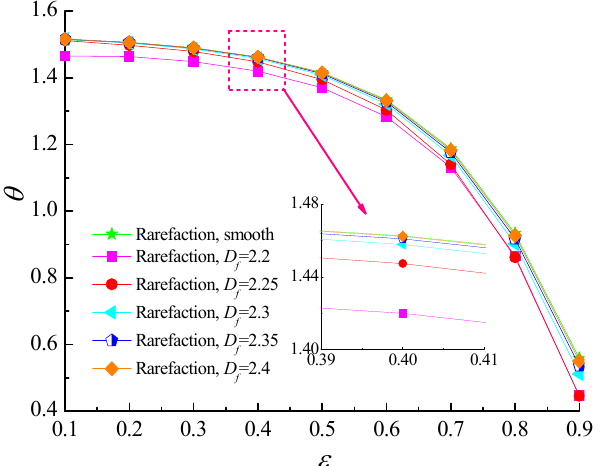
Figure 7. Attitude angle versus eccentricity ratio for different fractal dimensions at Λ = 20, G = 1 × 10 − 11 .